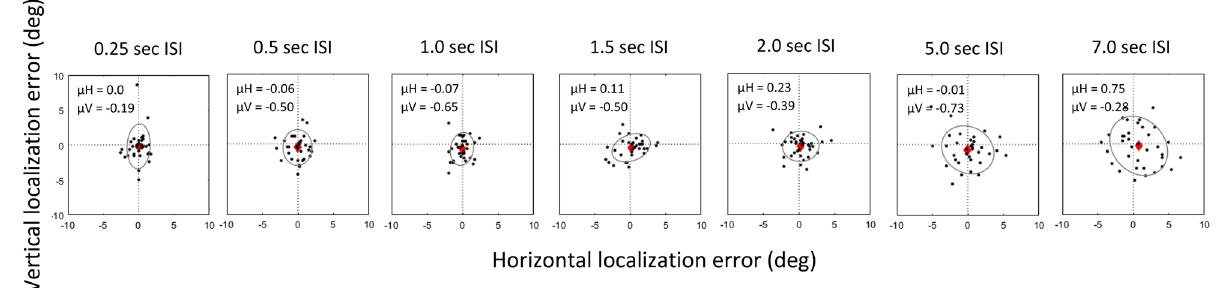
Figure 2. Scatter plot displaying horizontal and vertical localization error across inter-stimulus interval (S6) under monocular viewing conditions. Black dots represent the error in localization for each trial. Red diamond marks the mean horizontal and vertical error in localization across trials providing an estimate of accuracy of localization. BCEA (precision of localization) is the area represented by the grey ellipse.